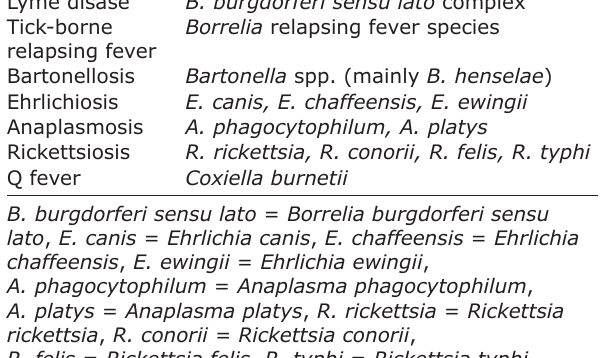
Table-1: Canine bacterial vector-borne zoonotic diseases. The bacterial agents of each disease are listed.